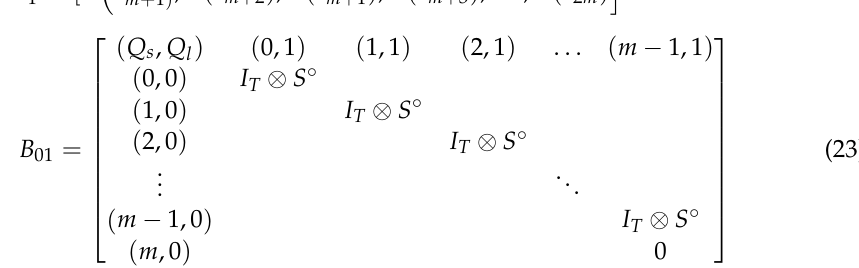
Figure 8. Transfer diagram of the generation and extinction process.